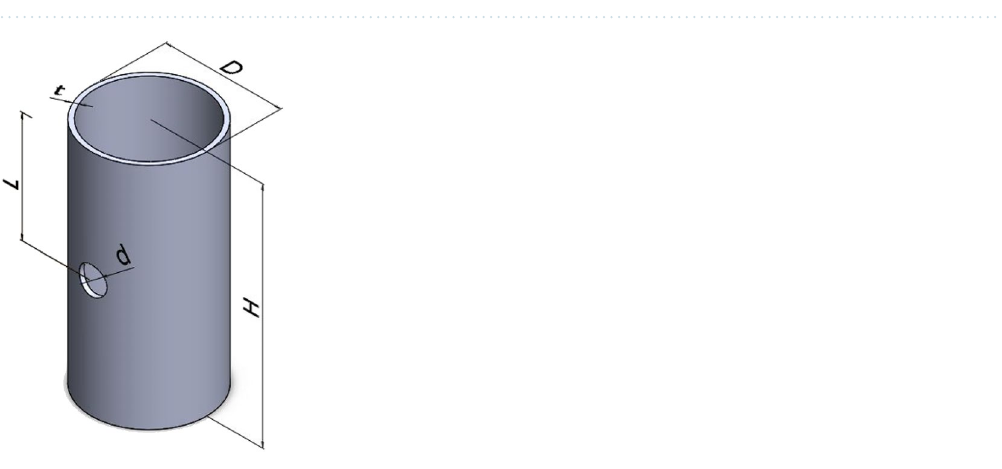
Figure 2. Steps of fabricating Al/GFRP composite tubes.